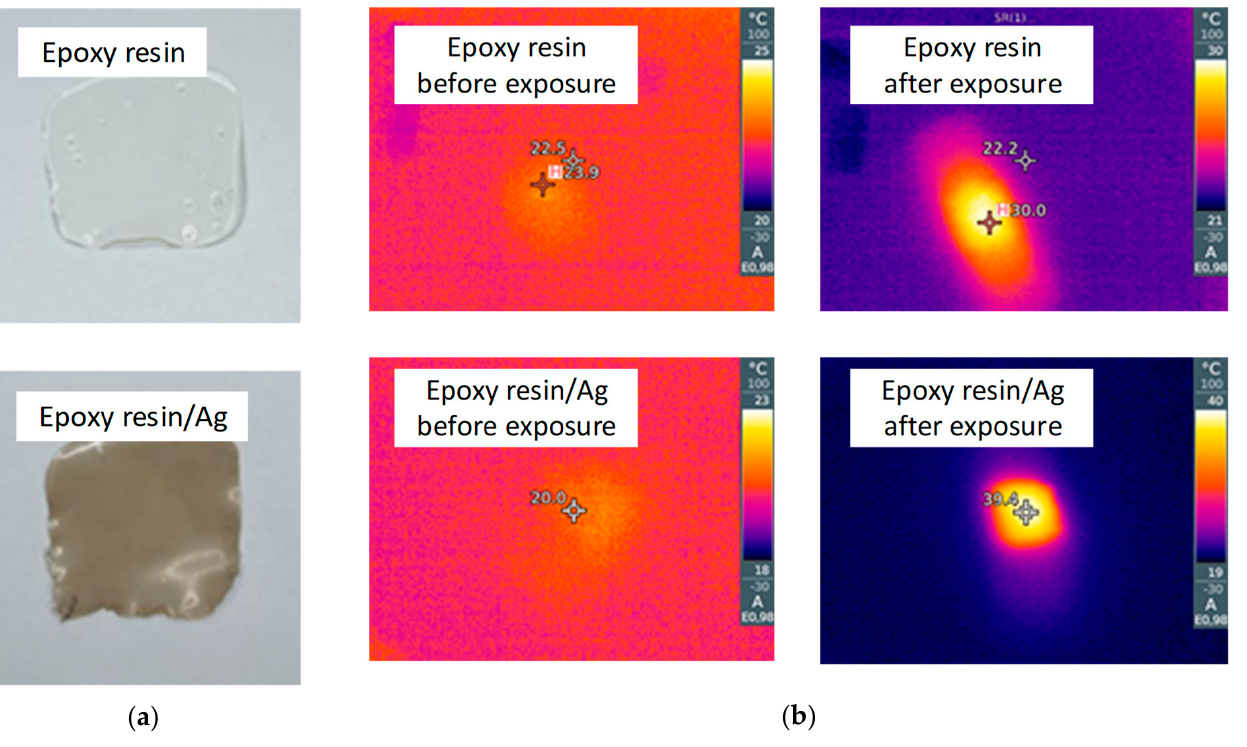
Figure 5. The study of the Ag nanoparticles thermal properties: ( a ) the photographs of the Ag-free and Ag-containing samples of the epoxy resin, ( b ) the corresponding thermal images of the samples after the LED projector exposure for 30 min.